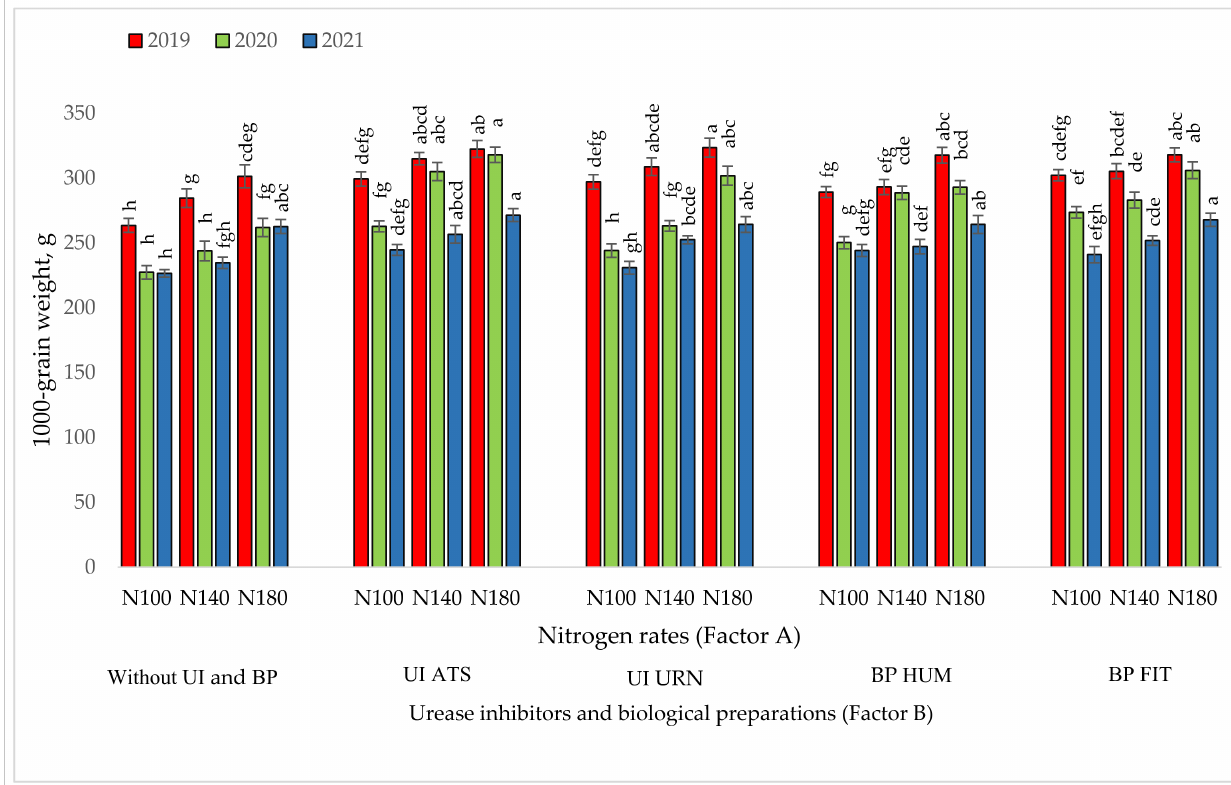
Figure 3. The influence of different nitrogen fertilizer rates, urease inhibitors, and biological prepara- tions on 1000-grain weight of maize, 2019–2021. UI—urease inhibitor; ATS—ammonium thiosulfate; URN—N-butyl-thiophosphoric triamide (NBPT) and N-propyl-thiophosphoric triamide (NPPT); BP— biological preparation; HUM—suspension of humic and fulvic acids; FIT—suspension of Ascophyllum nodosum . The differences between the means of the treatments with the different letters are significant ( p < 0.05). Vertical dashes indicate the mean